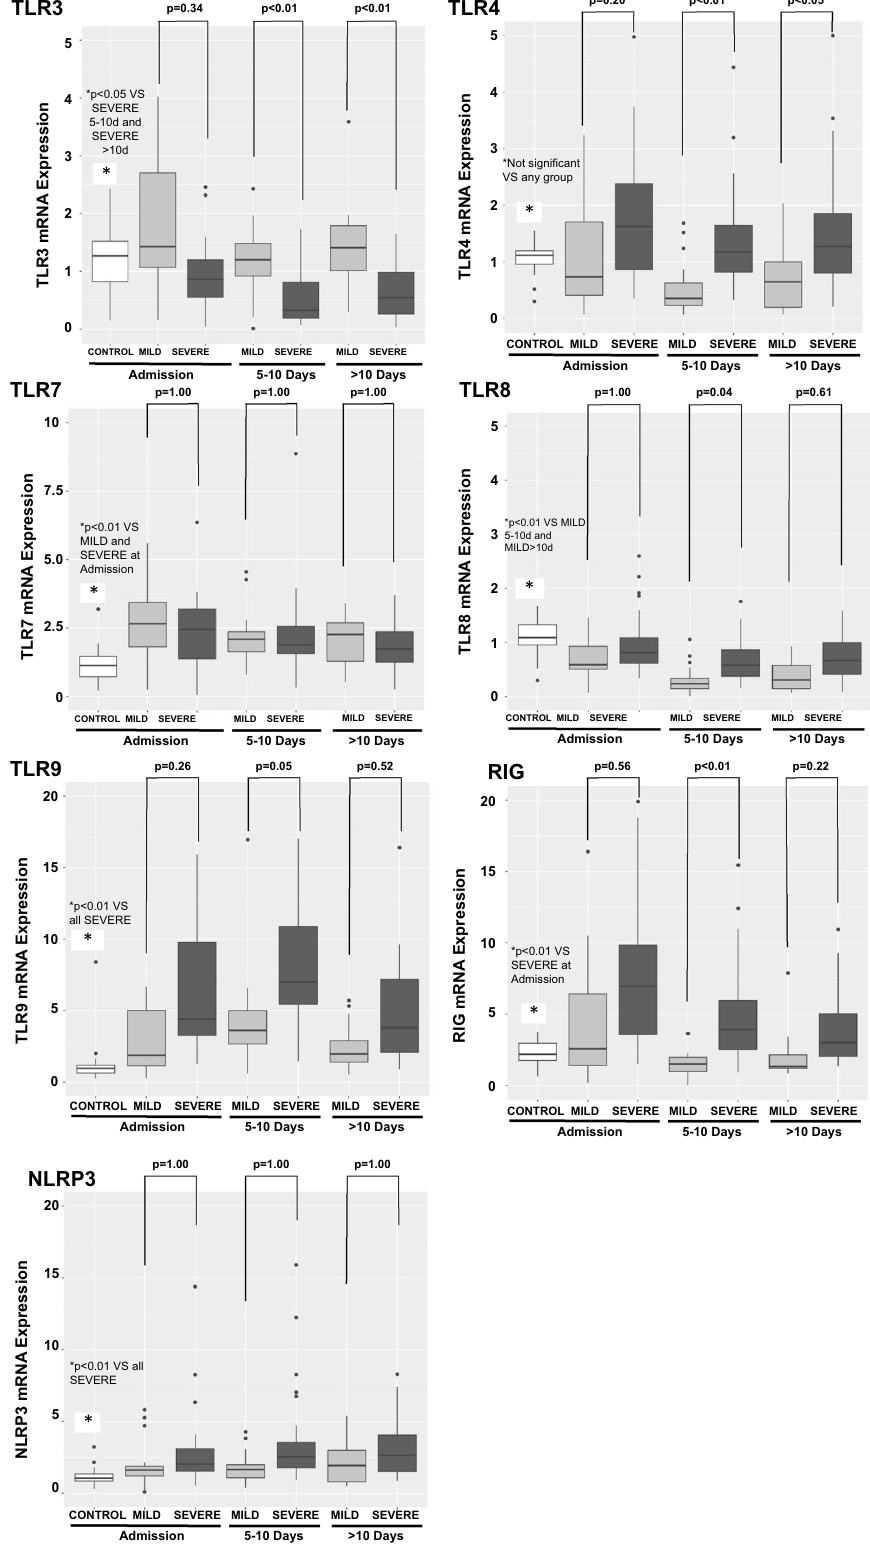
Figure 4. Quantitative mRNA of Pattern Recognition Receptors (PRRs) in circulating leukocytes of patients with COVID- 19 during hospital stay. Expression of PRRs (mRNA) was measured in circulating leukocytes. Blood samples were collected every five days as feasible during hospitalization. The difference between COVID-19 MILD (N = 17 patients) and COVID-19 SEVERE (N = 24 patients) TLR3 and TLR4 mRNA expression at admission widened during follow up. Controls are also shown (17 patients). P values were calculated using the nonparametric Kruskal–Wallis test in R software (version 4.0.3 for